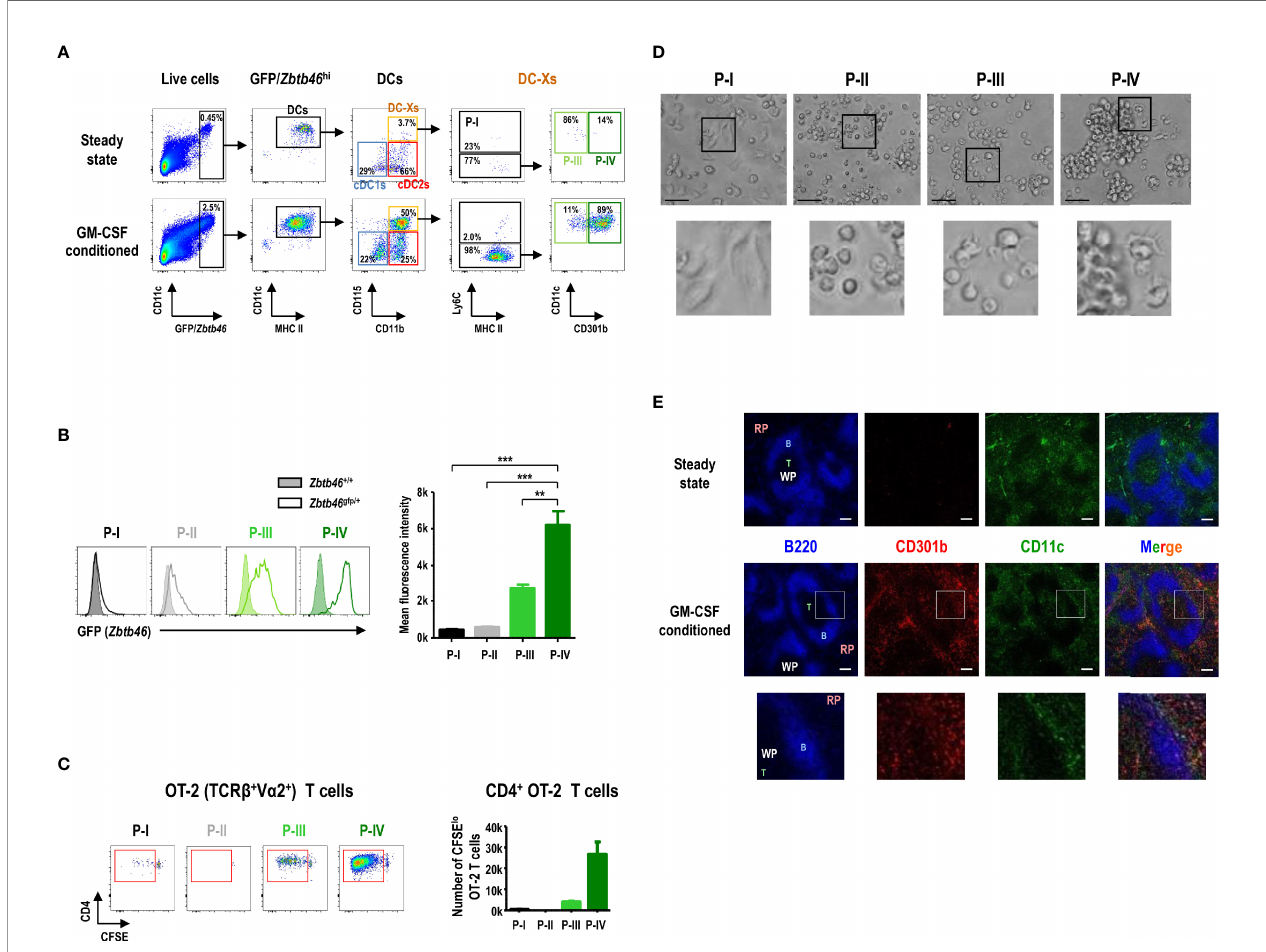
FIGURE 4 | CD115 hi CD301b + splenocytes are GM-CSF-induced DCs (GMiDCs). (A) Gating strategy showing the distribution of GFP/ Zbtb46 hi splenocytes within the respective DC and CD11b + CD115 hi cell subsets in control and GM-CSF-treated Zbtb46 gfp/+ mice. Representative fl ow cytograms (n = 2 mice for each condition). (B) Expression level of GFP (i.e., Zbtb46 gene) in splenic CD11b + CD115 hi cell subsets by comparing between Zbtb46 gfp/+ (line histograms) and Zbtb46 +/+ (shaded histograms) mice treated with GM-CSF. Data are shown in mean ± SEM of MFI for GFP signal in each cell subset from GM-CSF-treated Zbtb46 gfp/+ mice (n = 3 mice). **p ≤ 0.01; ***p ≤ 0.001; one-way ANOVA test. (C) Proliferation of CFSE-labeled naive CD4 + OT-2 T cells after co-culture (at an APC to T cell ratio of 1:5) with CD11b + CD115 hi cell subsets isolated from the spleen of GM-CSF-treated mice loaded with blood-borne OVA for 1 hour. Data are shown in mean ±